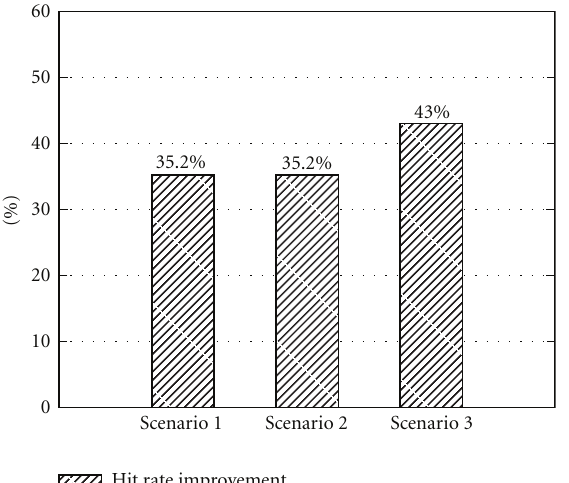
Figure 6: Tra ffi c volume reduction—based on reference scenario.